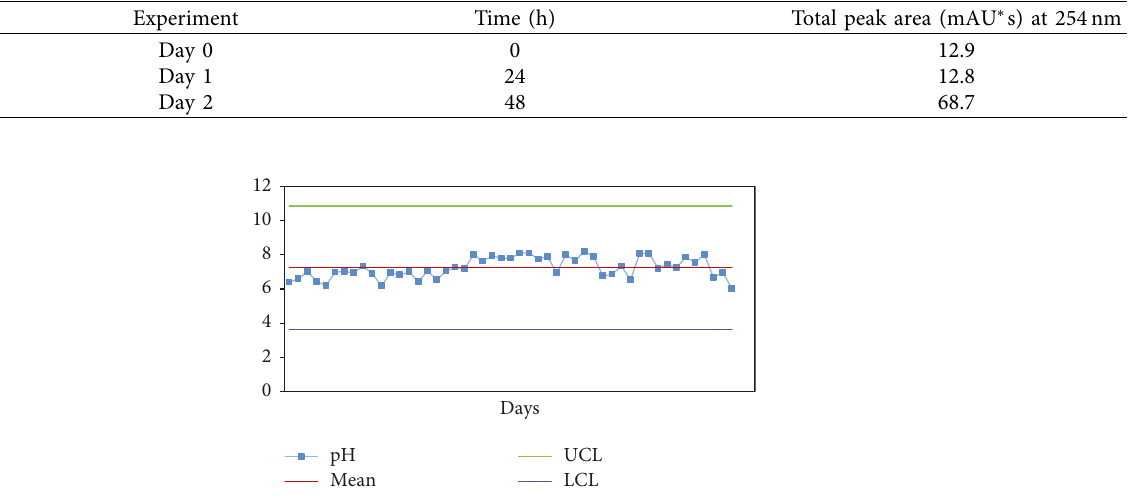
Table 5: Pilot HPLC stability results of ultrapure water.